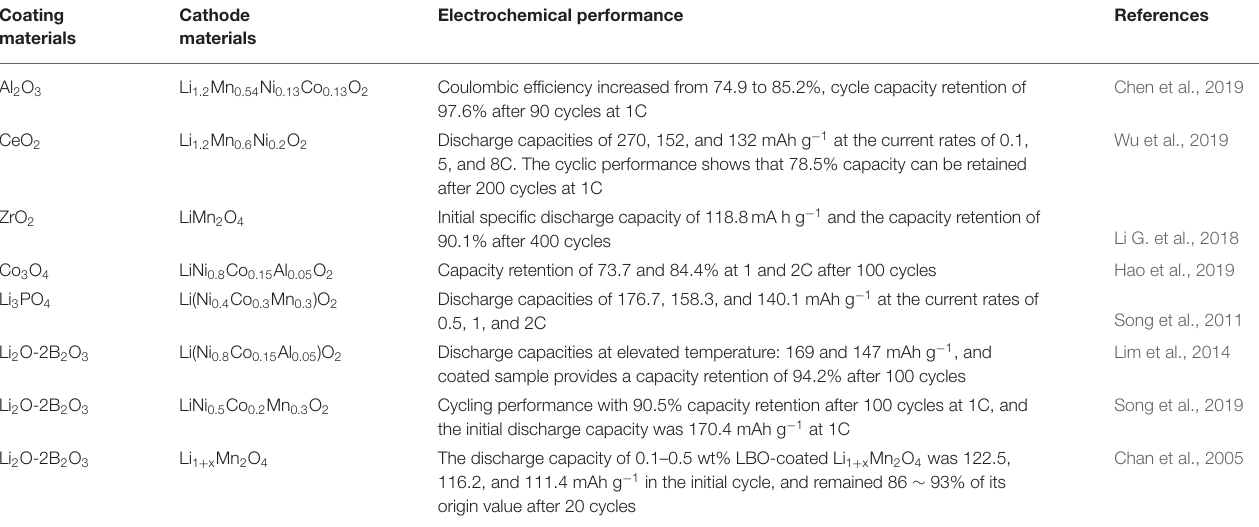
TABLE 1 | Improvement of electrochemical properties of cathode materials by coating. Coating